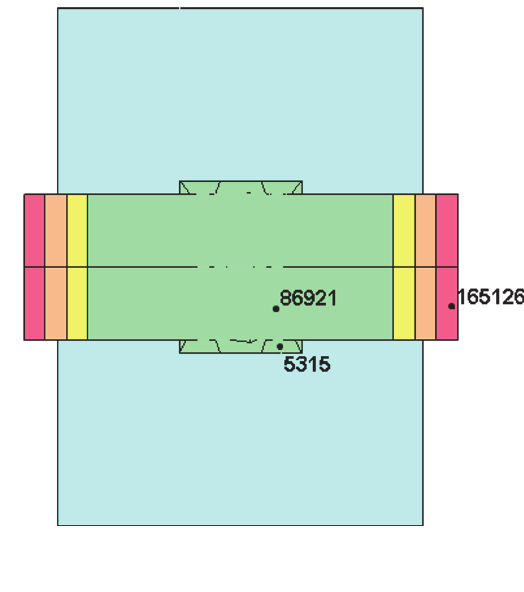
Figure 16: Location of typical nodes.